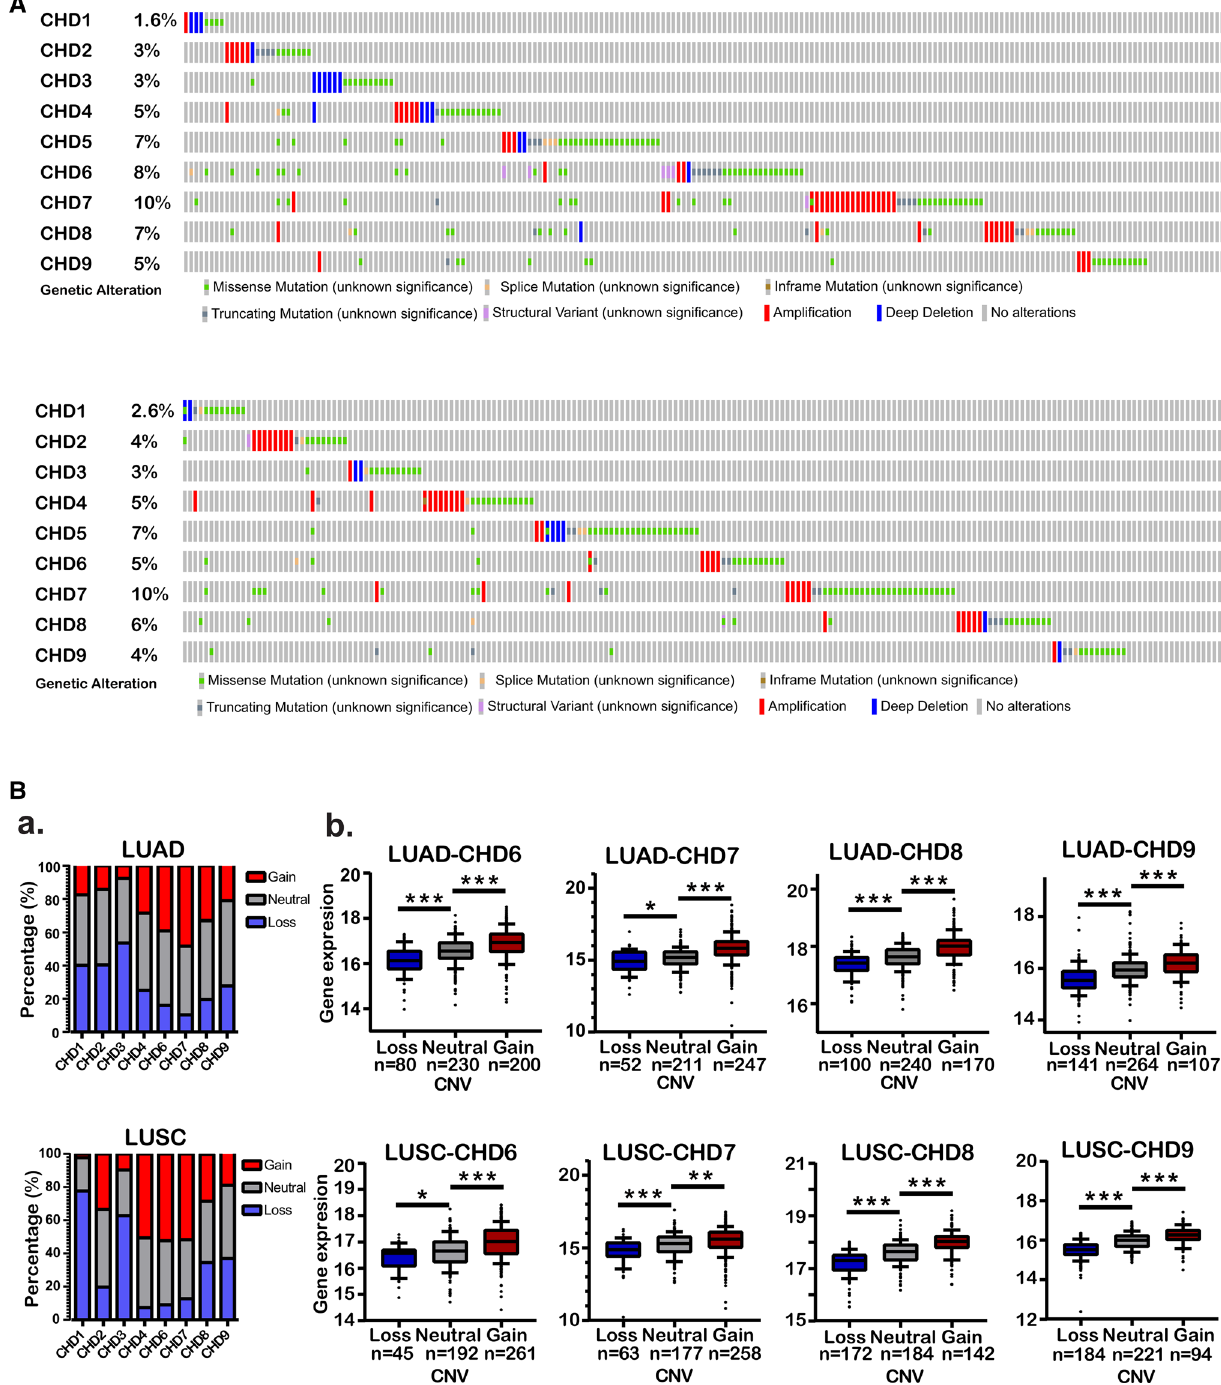
Fig. 2 The association of CHD expression with genetic alterations in lung cancer. A OncoPrint showing the distribution and proportion of samples with genetic alterations in CHD genes in LUAD and LUSC; B a The contribution of copy number variation to gene expression vari- ation in LUAD and LUSC; b Left panel, the proportion of samples with copy number variations for each CHD gene in LUAD or LUSC. Right panel, the correlation of copy number variation and CHD